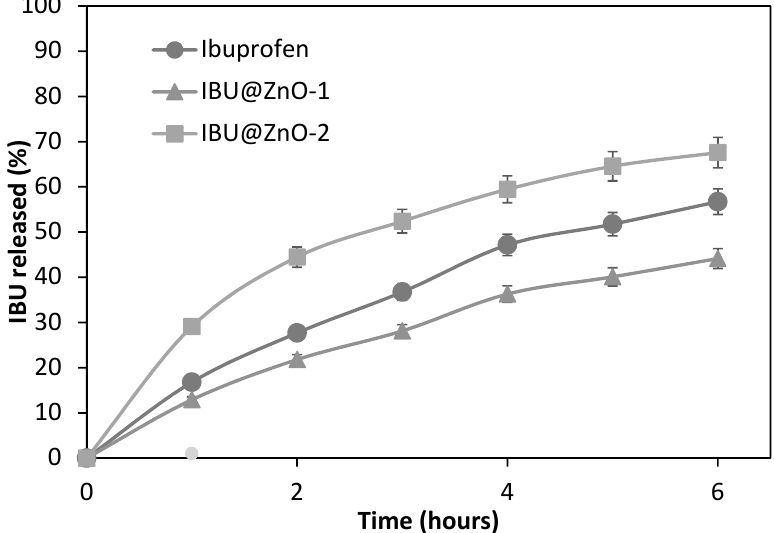
Figure 7. In vitro Zn 2+ release from NsZnO-1 and NsZnO-2.